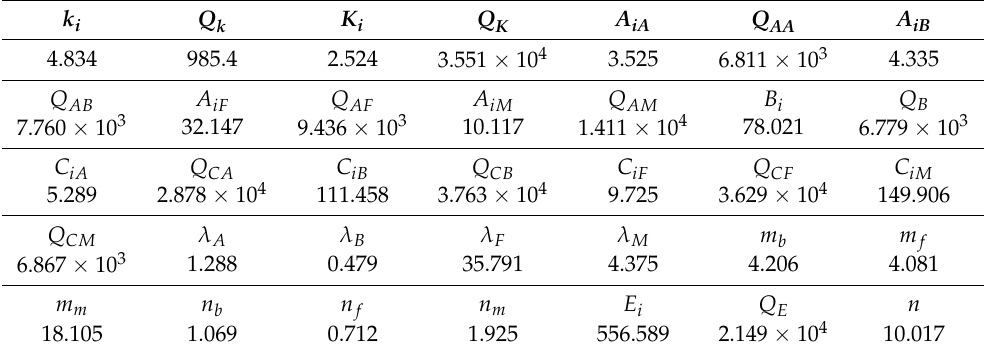
Table 2. The material constants for the proposed constitutive